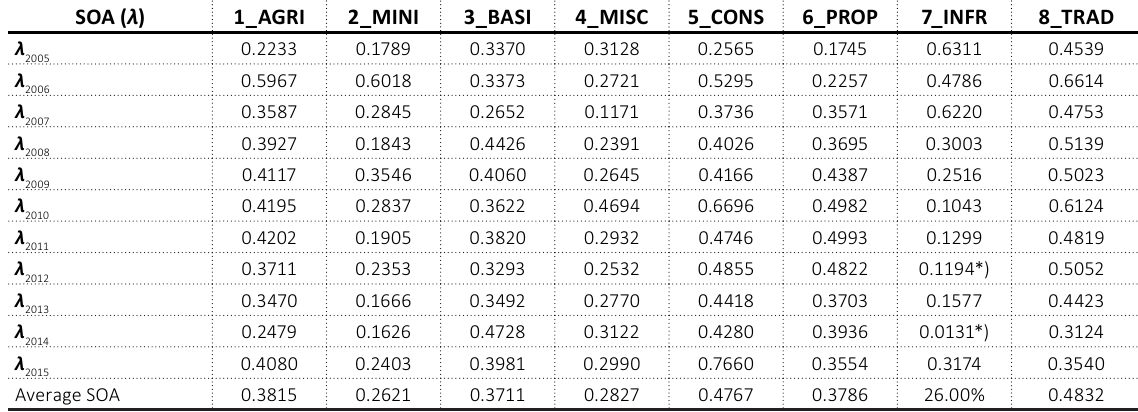
Table 7. Impact of industry specific variable on SOA